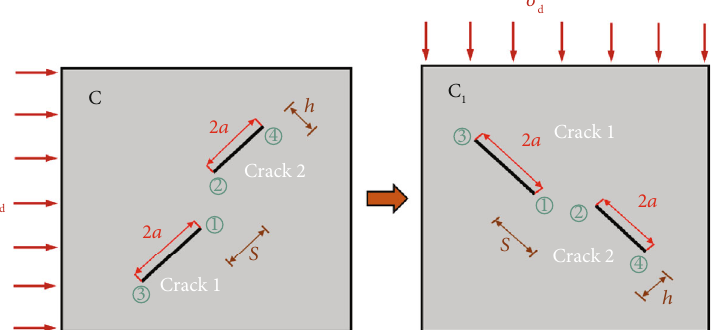
under biaxial compression. 1